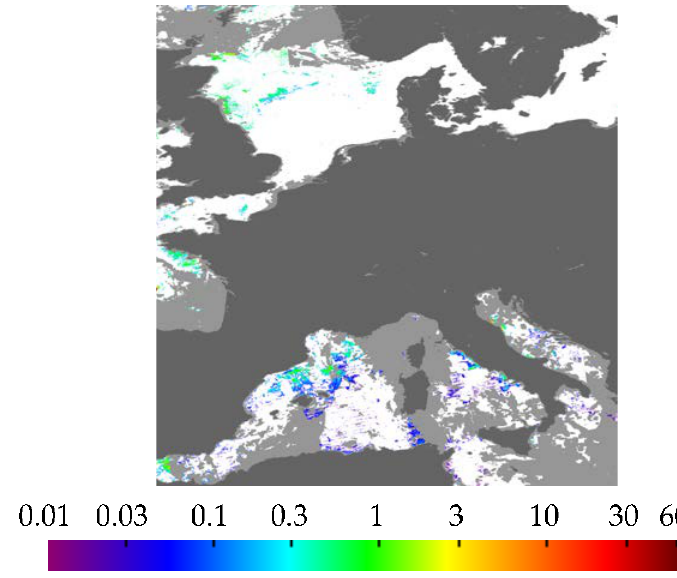
Figure 8. Natural chl variation used to account for variability greater than the uncertainty predicted by the model. Light grey regions have fewer than two measurements, white regions are zero.